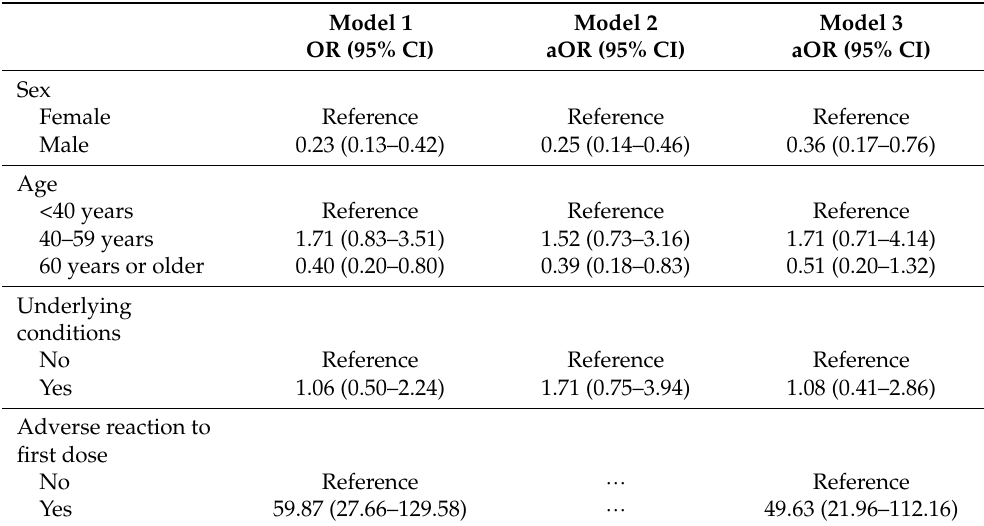
Table 2. Factors associated with any adverse reaction (either local or systemic adverse reaction), after the second dose of COVID-19 mRNA